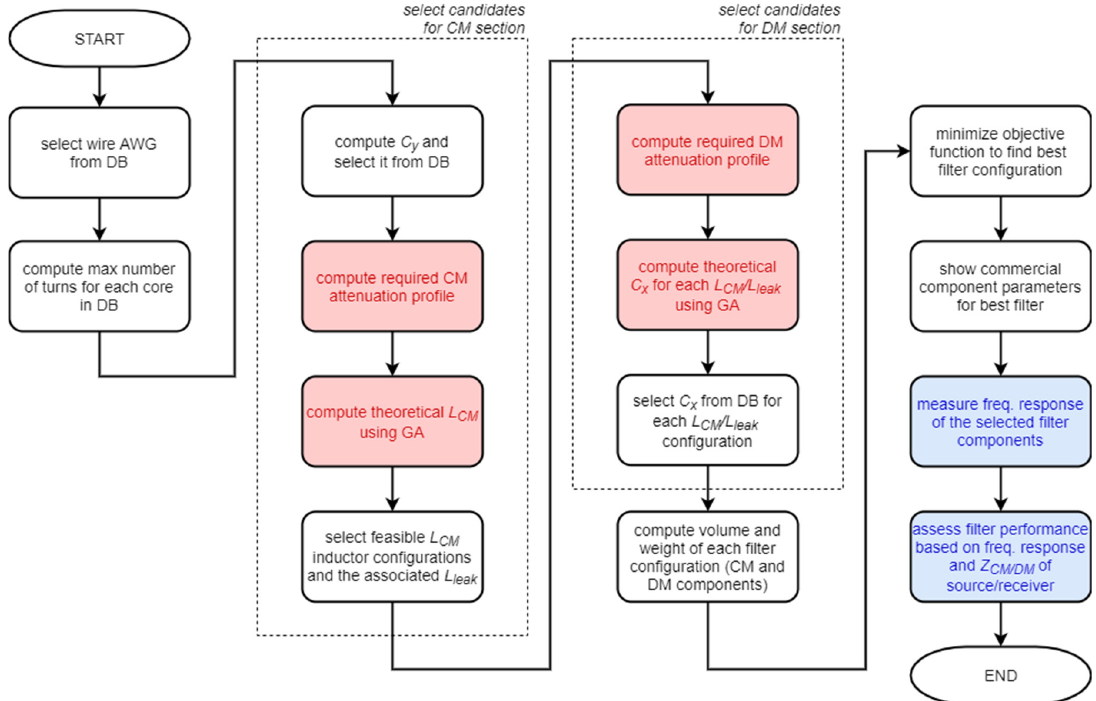
Figure 7. Flowchart of the proposed procedure.